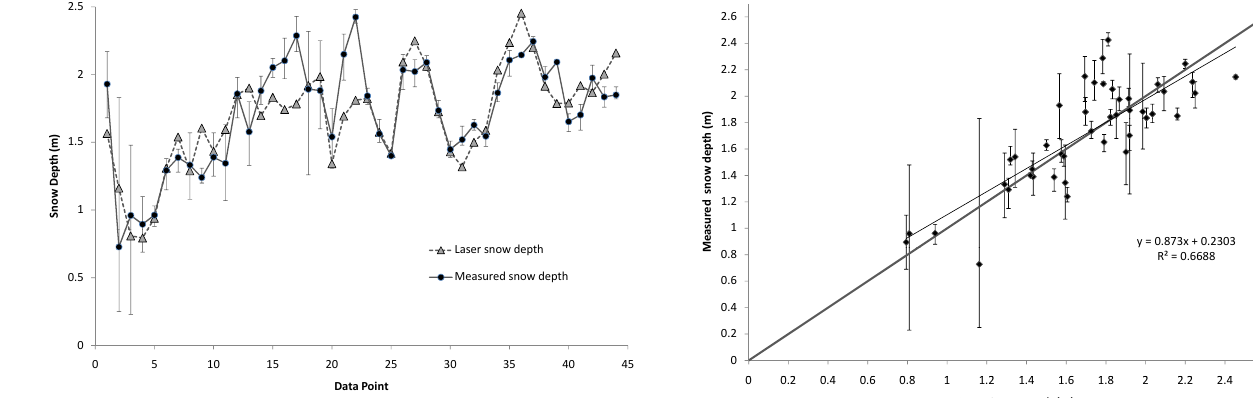
Fig. 5. Scatter plot of manually measured versus laser snow depth at the validation slope. Error bars show the variation in measured snow